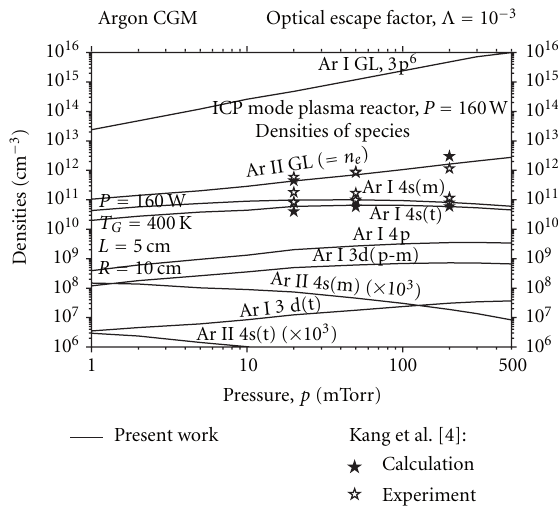
Figure 7: As in Figure 6 but including an optical escape factor for the 4s(t) Ar I level. Theoretical and experimental results from [4] are also included.